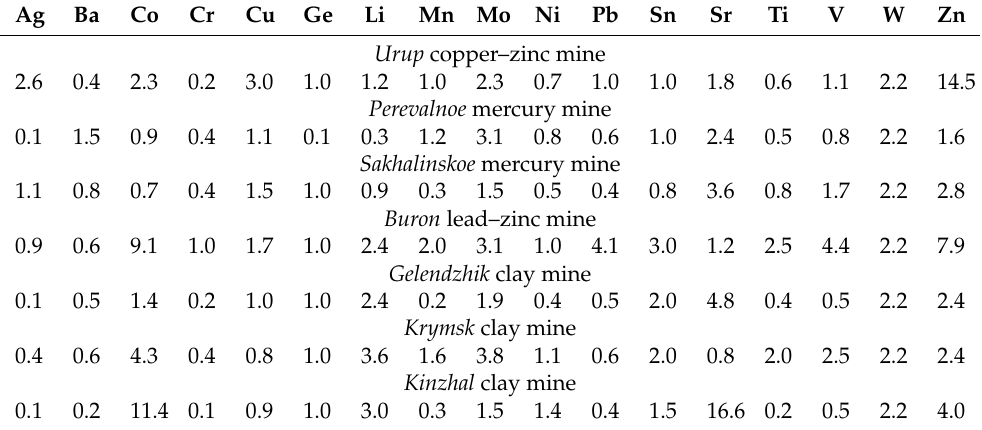
Table 6. Enrichment factors (EFs) of the chemical elements in the ash of leaves and needles of plants from the mined deposits of the North Caucasus geochemical province, calculated in relation to the regional abundances of the